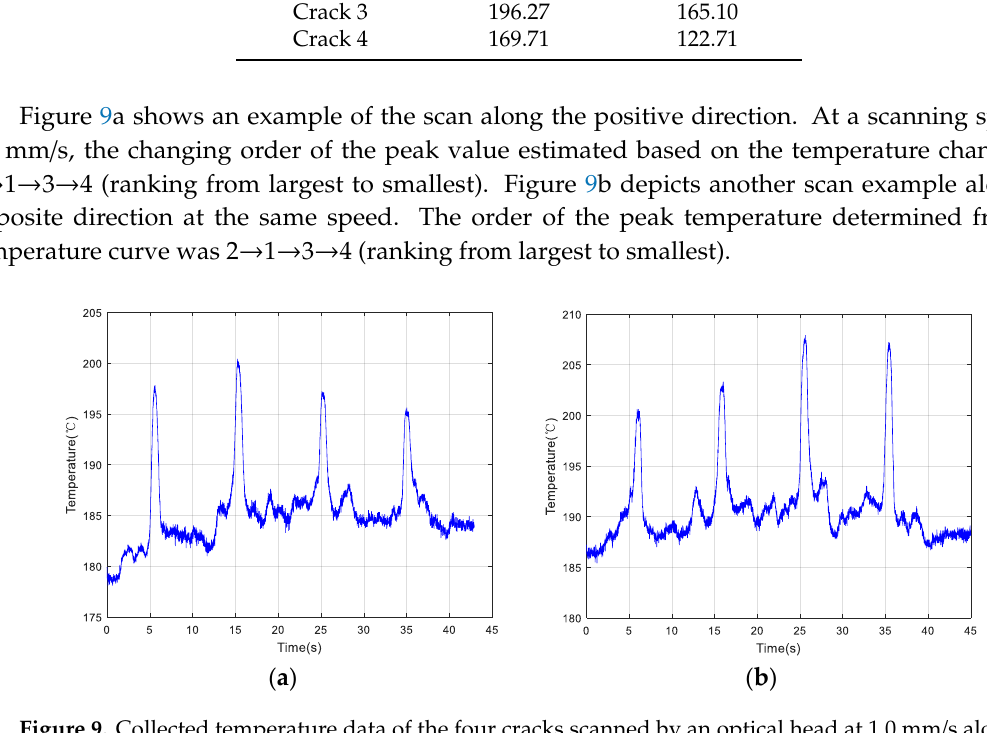
Figure 9. Collected temperature data of the four cracks scanned by an optical head at 1.0 mm/s along the ( a ) positive direction and ( b ) opposite direction.